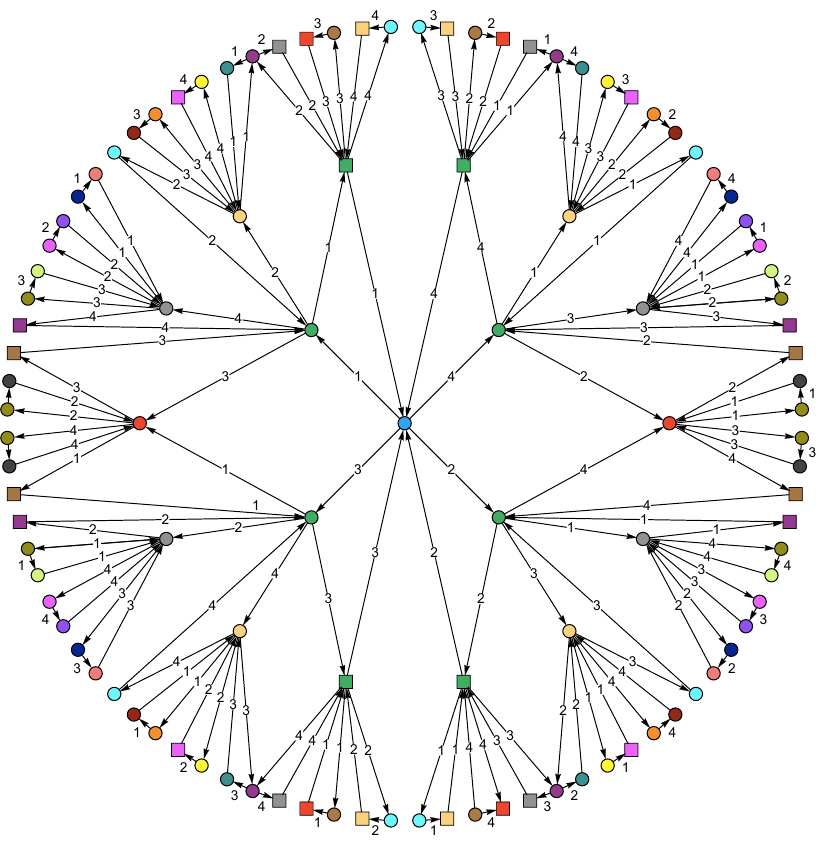
Figure 8. Duality web for both S t and S e . The web is in(cid:12)nite and we only present a portion of it here. The seed, i.e. either S t or S e , corresponds to the blue circle at the center of the web. Over every arrow we indicate mutated